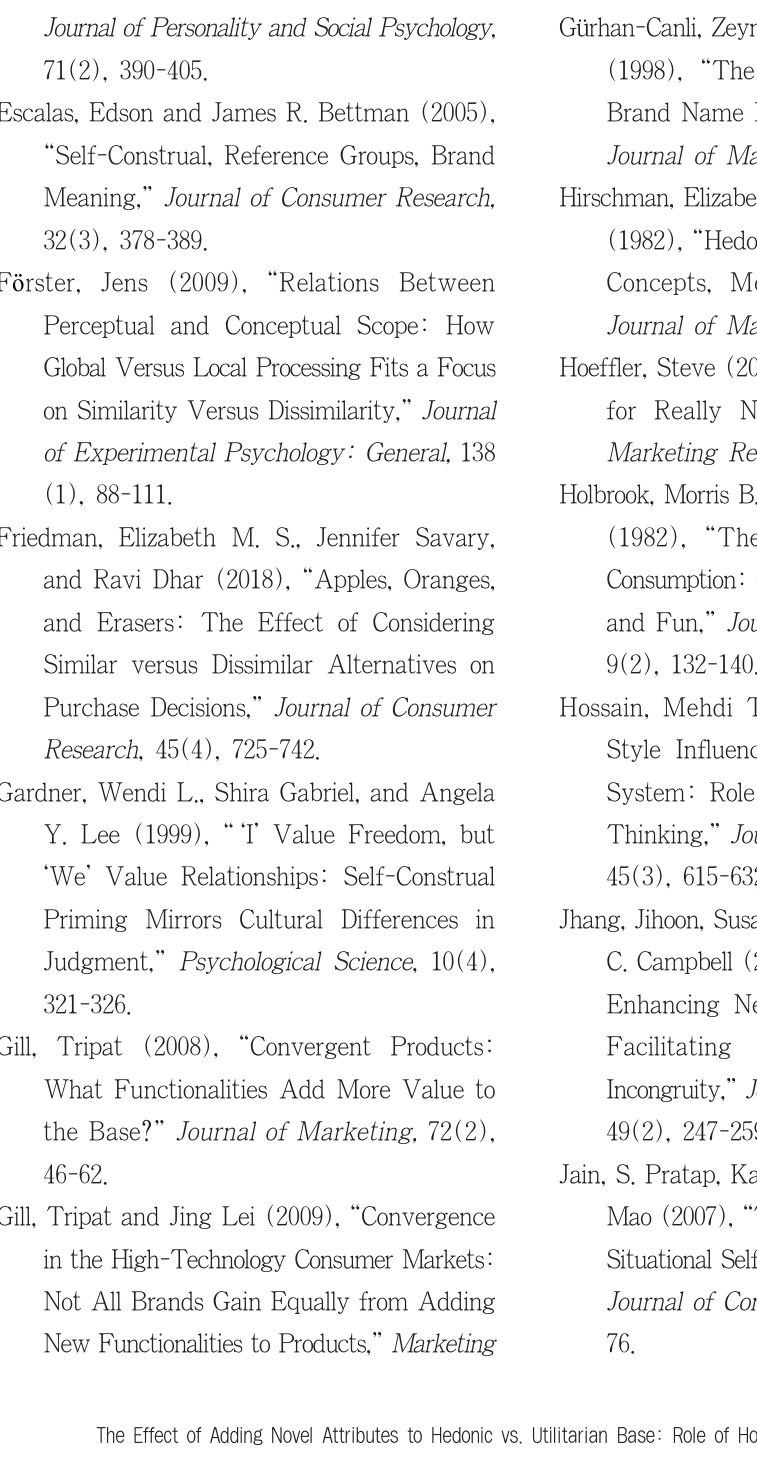
The Effect of Adding Novel Attributes to Hedonic vs. Utilitarian Base: Role of Holistic vs. Analytic Thinking Style